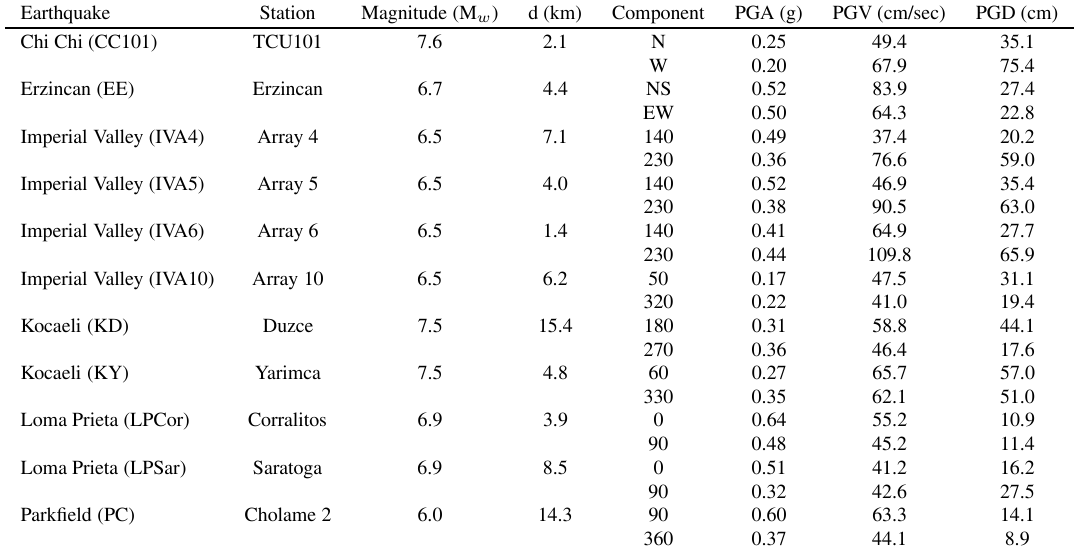
Table 2 Characteristics of near- fi eld ground motions in